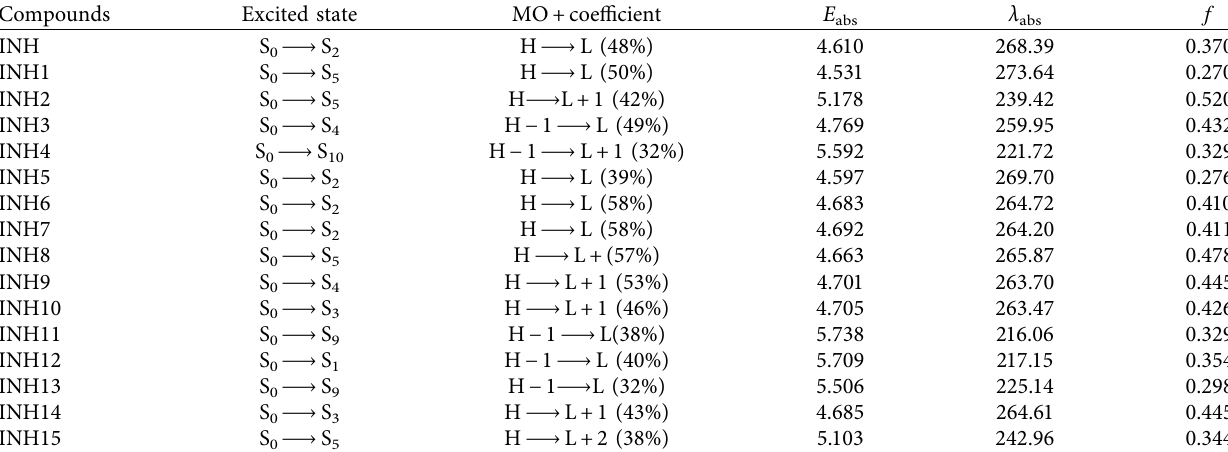
Table 4: Excitation energies, wavelengths, oscillator strengths, molecular orbitals, and dominant electronic transitions of the studied compounds obtained at the CAM-B3LYP/6-311G (d,p) level of theory in the gaseous phase.